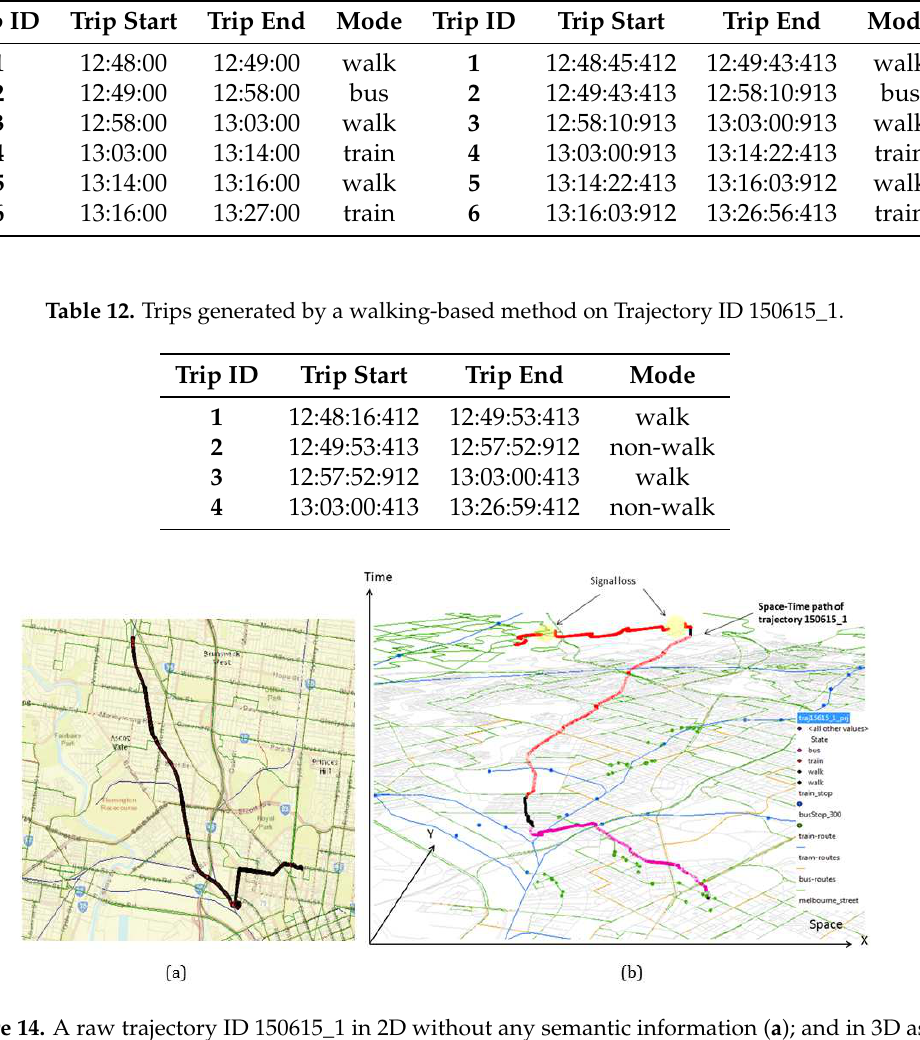
Figure 14. A raw trajectory ID 150615_1 in 2D without any semantic information ( a ); and in 3D as a space-time path with semantic information such as different trips with their start and end in space-time, modes used, travel direction, signal gap, and travel speed ( b